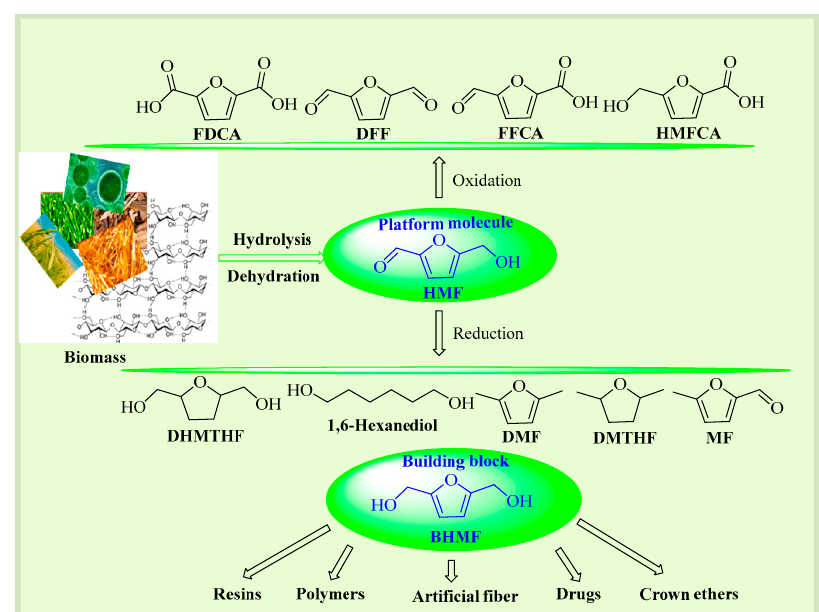
Figure 1. Schematic illustration for upgrading bio-based HMF to value-added products. (HMF: 5-hydroxymethylfurfural, BHMF: 2,5-bis(hydroxymethyl)-furan, FDCA: 2,5-furandicarboxylic acid, DFF: 2,5-diformylfuran, FFCA: 2-formyl-5-furancarboxylic acid, DMF: 2,5-dimethylfuran, HMFCA: 5-hydroxymethyl-2-furancarboxylic acid, DHMTHF: 2,5-dihydroxymethyl-tetrahydrofuran, DMTHF: 2,5-dimethoxytetrahydrofuran, MF: 5-methylfurfural).